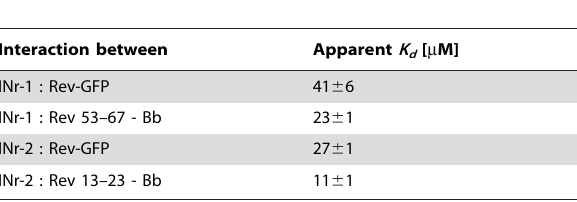
Table 2. Quantitative characterization of the interaction between the INrs and Rev-GFP or Rev-derived peptides.